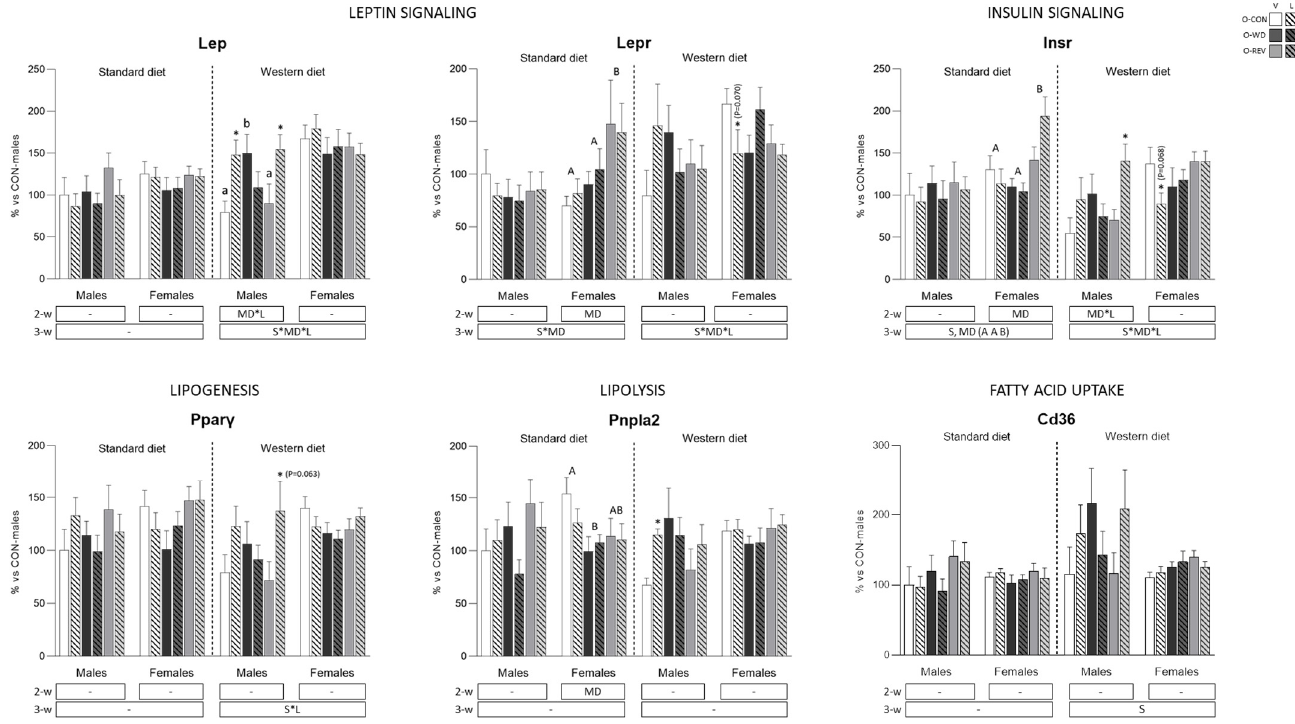
Figure 6. Expression levels of genes related to energy metabolism in retroperitoneal white adipose tissue of O-CON, O-WD and O-REV male and female animals treated with vehicle or leptin during suckling and fed SD or WD from weaning, at four months of age. Data are mean ± SEM ( n = 8–12). Statistics: After data separation depending on post-weaning diet, three-way ANOVA was performed to analyze the effect of sex, maternal diet and/or leptin treatment. In each sex, two-way ANOVA was performed to analyze the effect of leptin treatment and/or maternal diet. When an interactive effect was found, one-way ANOVA was performed to analyze the effect of maternal diet in each treatment. Single comparisons between leptin versus vehicle-treated rats of all experimental groups were carried out using Mann-Whitney U test. Symbols: sex (S), maternal diet (MD), leptin treatment (L); A (cid:54) = B ( p < 0.05, LSD post-hoc, two-way ANOVA); a (cid:54) = b ( p < 0.05, LSD post-hoc, one-way ANOVA); *, different from their vehicle-treated equal ( p < 0.05, Mann-Whitney U test). Abbreviations: offspring of CON-dams (O-CON), offspring of WD-dams (O-WD), offspring of REV-dams (O-REV), vehicle (V), leptin